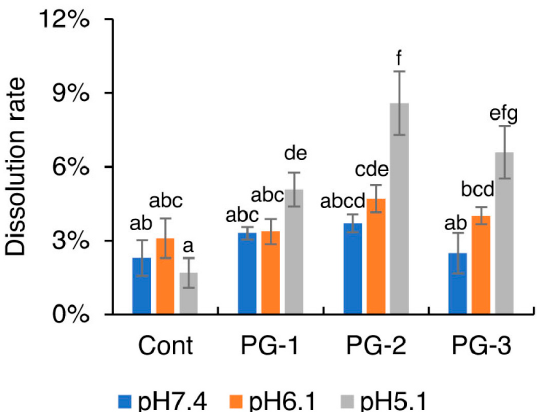
Figure 4. Solubilities of the four glass particles: Cont., PG-1, PG-2, and PG-3 in pH-adjusted BHI broth. Bars represent the standard deviation of the three replicates. a–g: different letters indicate significant differences ( p < 0.05, ANOVA, Tukey’s HSD test).